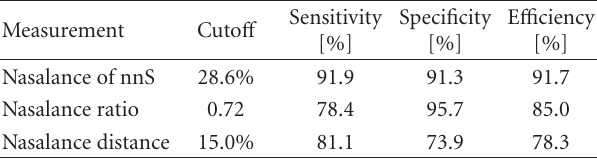
Table 4: Validation data for di ff erentiation between patients with regular resonance and hypernasal patients excluding borderline cases.